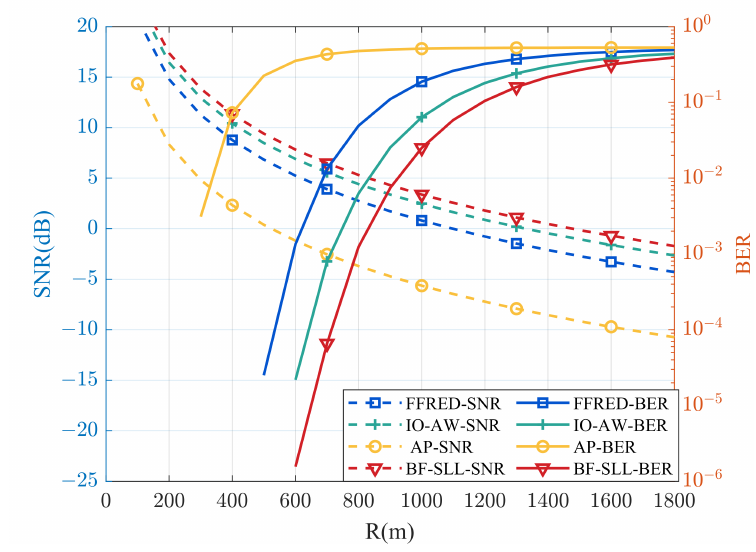
Figure 8. Bit error rate (BER) versus the range of different